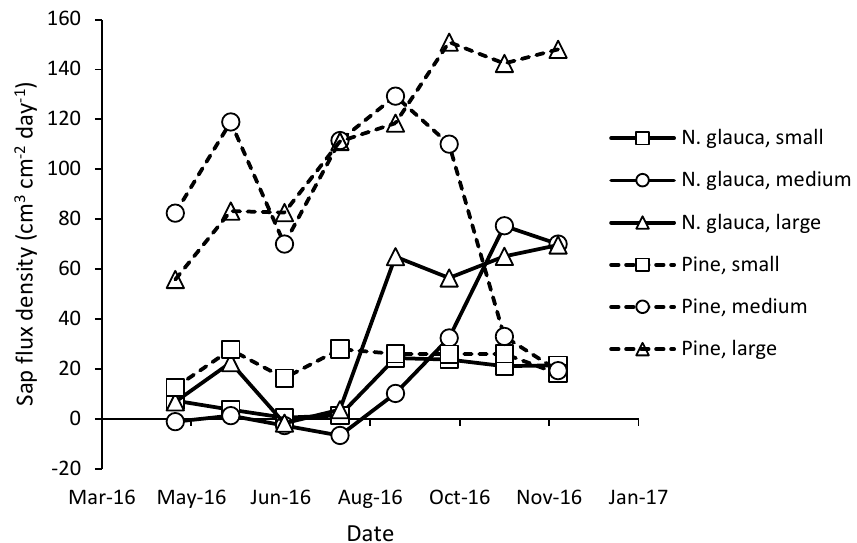
Figure 3. Time course of the average daily value of sap flux density for each month between May and December 2016. The measurements for each of the three N. glauca and P. radiata trees are shown separately.